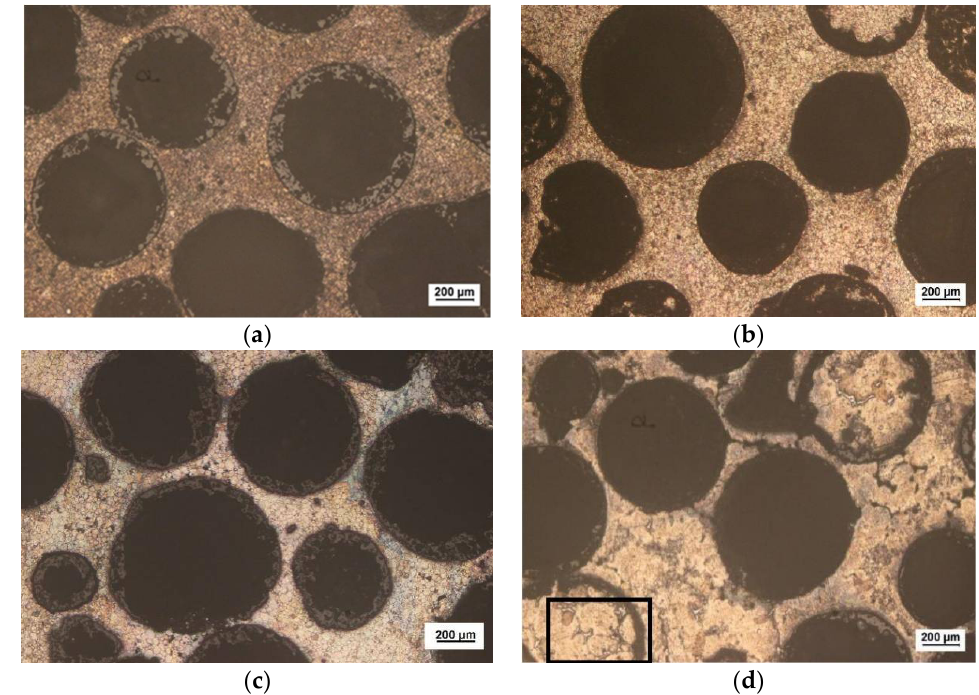
Figure 4. Microstructure of Al 2 O 3hs /AZ91D prepared at different temperatures: ( a ) 663 K, ( b ) 693 K, ( c ) 723 K, and ( d ) 753 K.